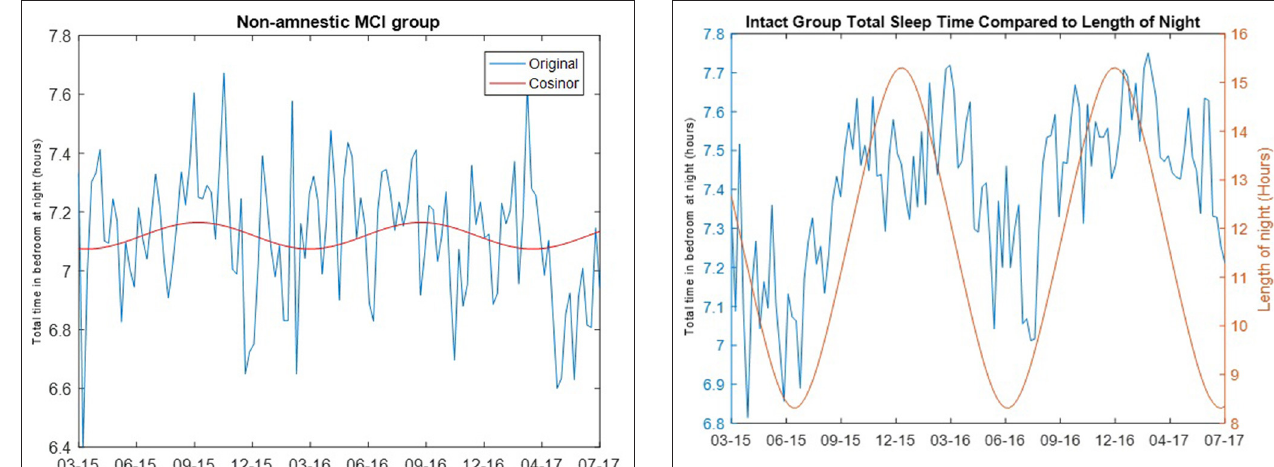
FIGURE 2 | Cosinor fit of total time in bedroom of non-amnestic MCI group, showing a weaker relationship between total time in bedroom at night and day of year as seen in the intact group.